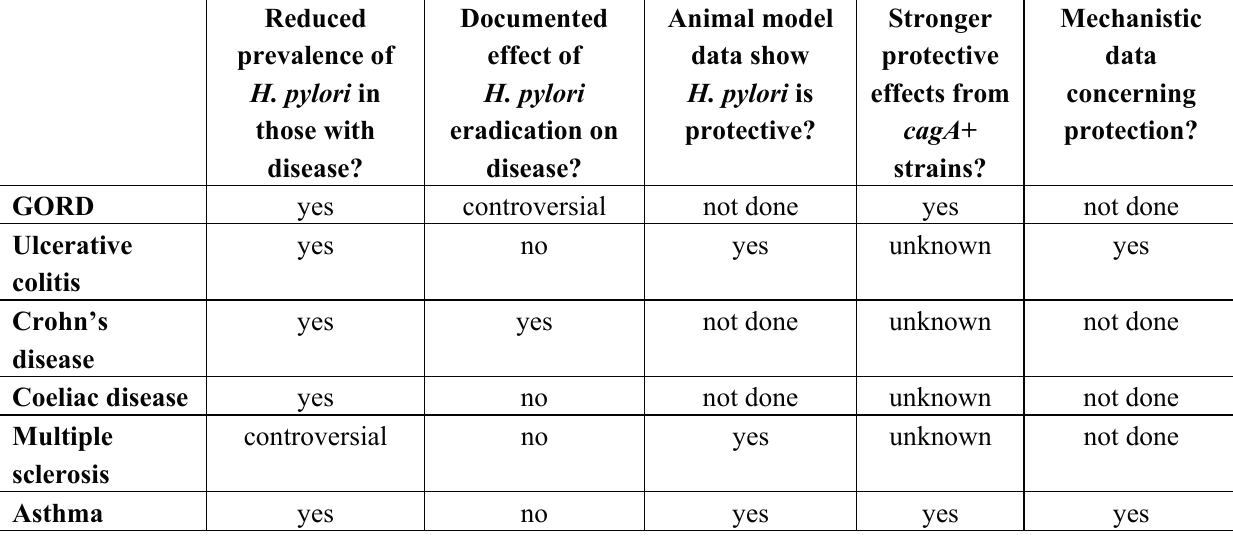
Table 2. Evidence gathered for H. pylori- mediated protection against extra-gastric diseases.